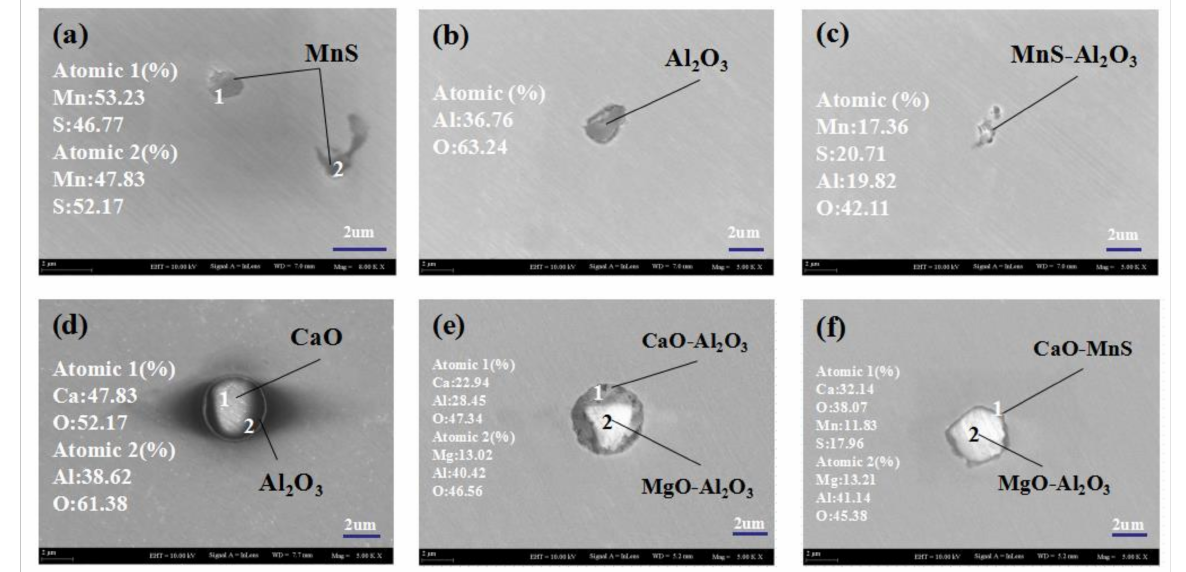
Figure 2. Typical non-metallic inclusions in steel at different stations ( a – c ) are pictures of non-metallic inclusions before calcium treatment; ( d – f ) are pictures of non-metallic inclusions after calcium